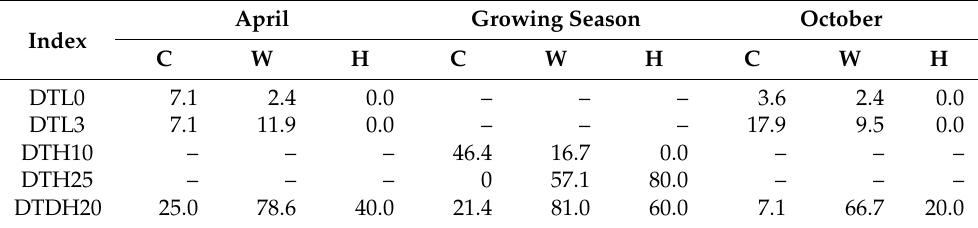
Table 3. Percentages (%) of stations with significant annual variability (based on the M-K test) in the temperature metric indices with ecological relevance across the climatic zones. The character “C” denotes cold areas; “W” denotes warm areas; “H” denotes hot areas; and “–” means no analysis of this index was conducted during the given seasons.